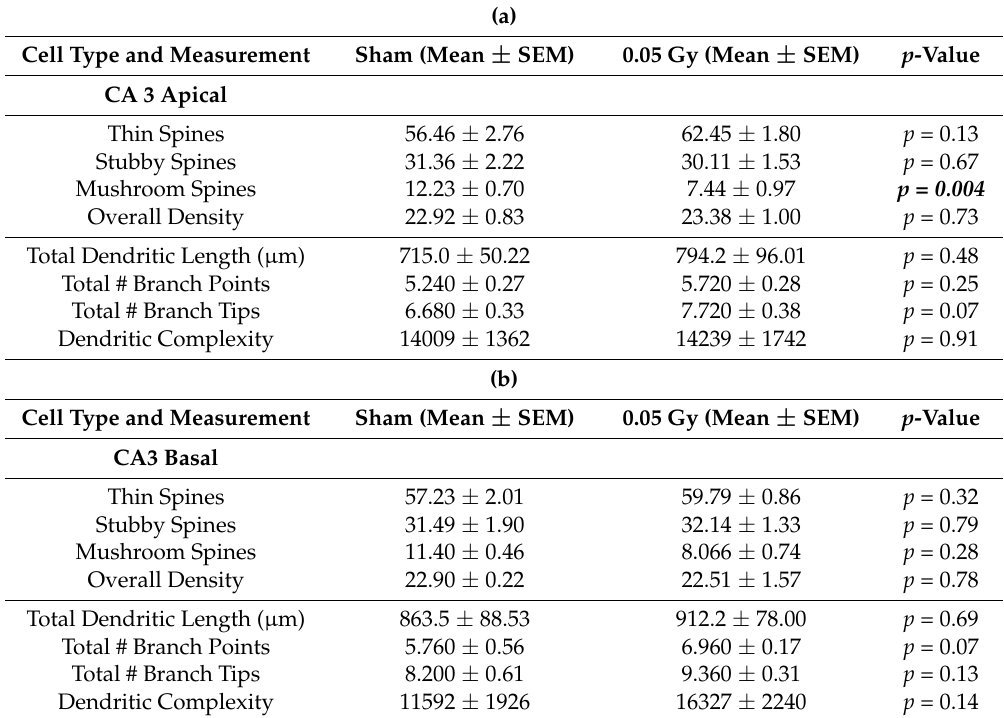
Figure 5. CA3 Sholl analyses and spine morphology. ( a , b ) 0.05 Gy radiation did not affect arborization CA3 apical and basal pyramidal dendrites. ( c , d ) Mushroom spine density was significantly lowered as a result of treatment. Average ± SEM ( n = 5); ** p < 0.01. Table 3. Effects of 16 O on dendrite morphology in the